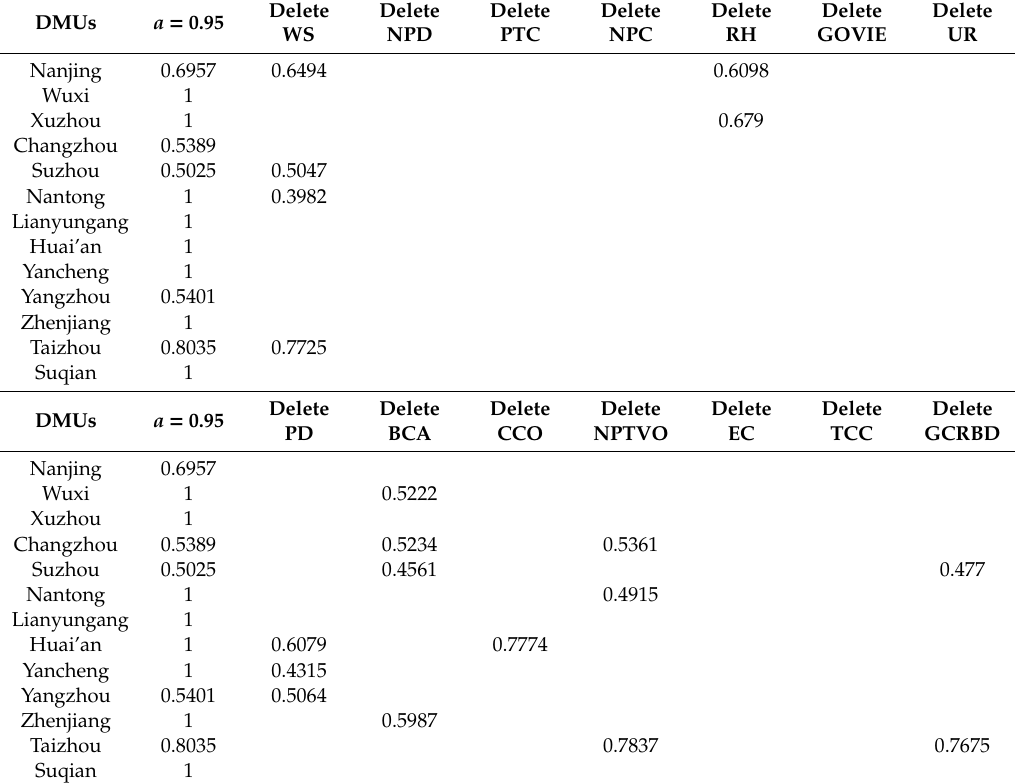
Table A5. The changes of stochastic e ffi ciency value by deleting single input variable in 2014 ( α = 0.95).